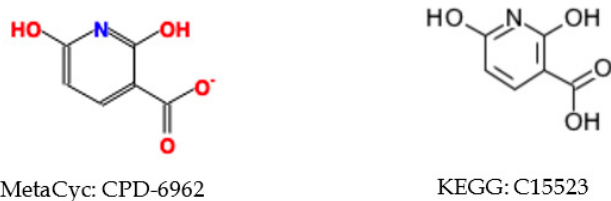
Figure 1. Correspondence between KEGG and MetaCyc compound entries with different molecular representations.